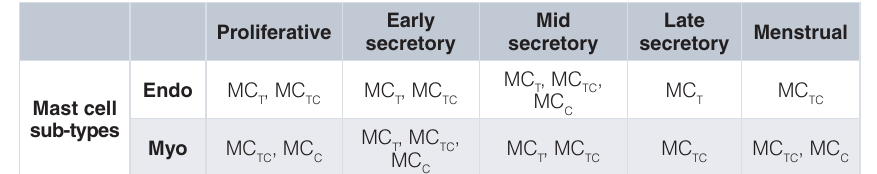
Table 1. Summary of uterine mast cell phenotypes documented in tissue samples collected across the menstrual